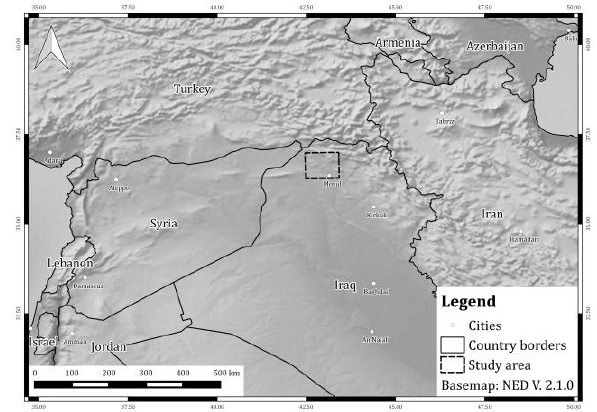
Figure 1. Location of the study area